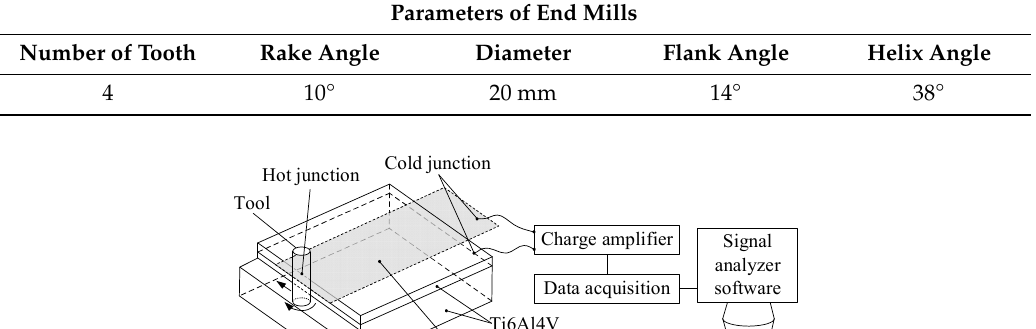
Table 1. Tool parameters for experiment [34]. Figure 14. A schematic of semi-artificial thermocouple temperature measurement device.